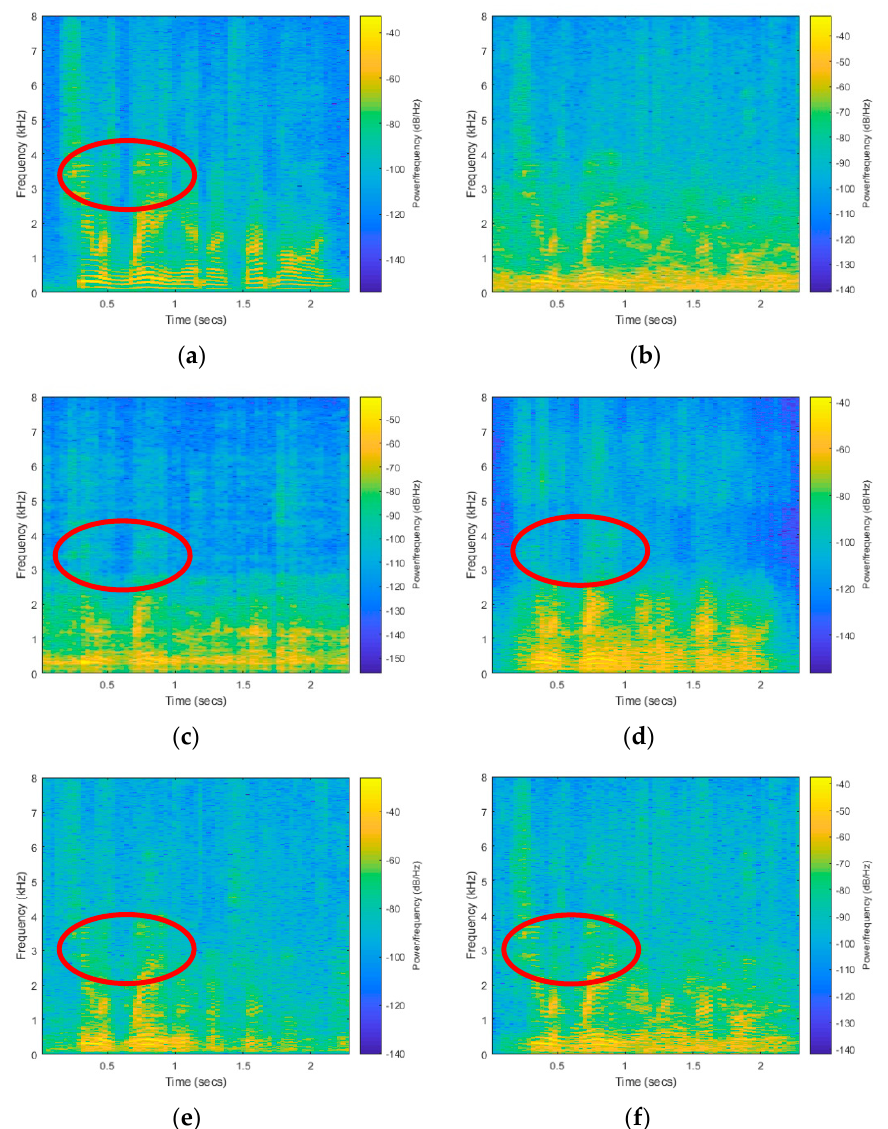
Figure 7. Spectrogram of ( a ) clean speech, ( b ) noisy, ( c ) STFT-NMF, ( d ) DWPT-NMF, ( e ) DNN-IRM, and ( f ) DTCWT-NMF where the x-axis corresponds to the time in seconds and the y-axis corresponds to the frequency in kHz.